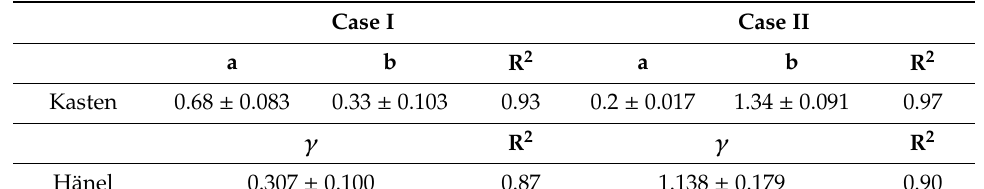
Table 3. Range of values and gradient values of the 𝑊 , the 𝜃 , the RH, the 𝛽 (cid:2873)(cid:2871)(cid:2870) , the depolarization ratio, the color ratio for Case I and Case II.